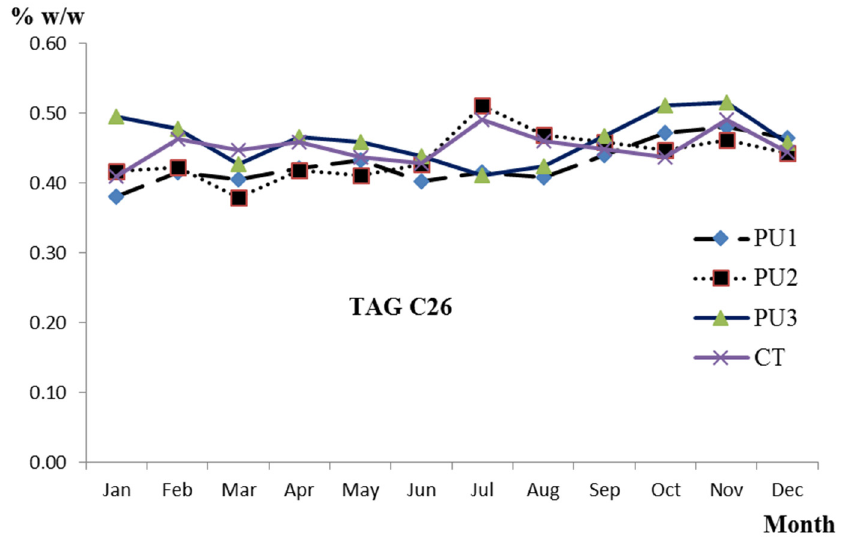
Figure 3. Distribution trend over time of mean values (% w / w ) of triacylglyceride C26 in organic milk produced in Tecpatán, Chiapas (PU 1, 2, 3, and CT).